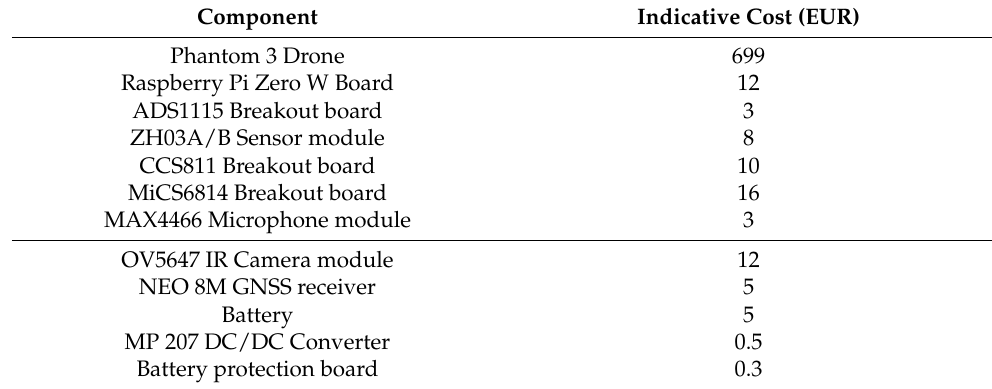
Table 1. Table reporting the breakdown of costs on the various components constituting the sensor- based